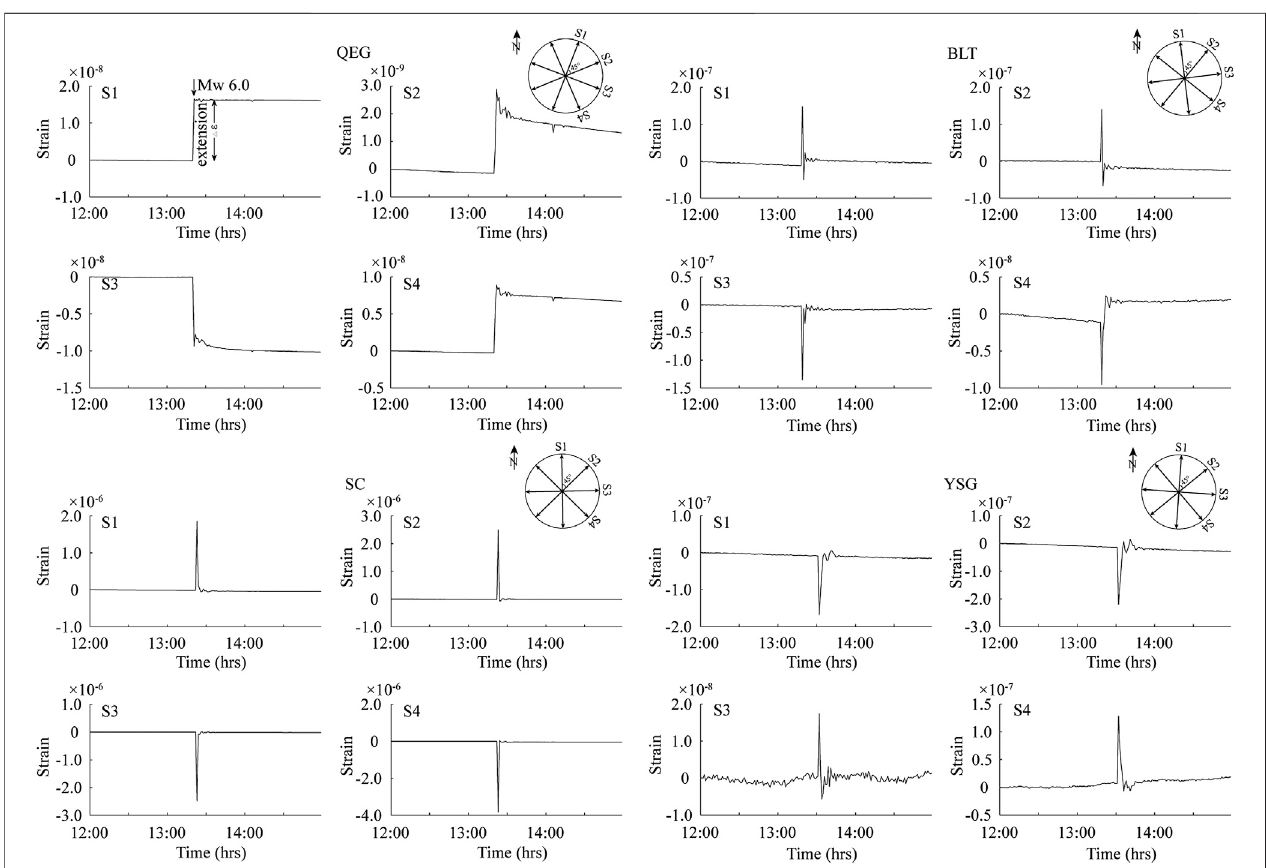
FIGURE 2 | Coseismic strain step curves recorded on four-component borehole strainmeters located at four borehole stations. Si (i (cid:1) 1, 2, 3, 4) represents a component of the borehole strainmeter.